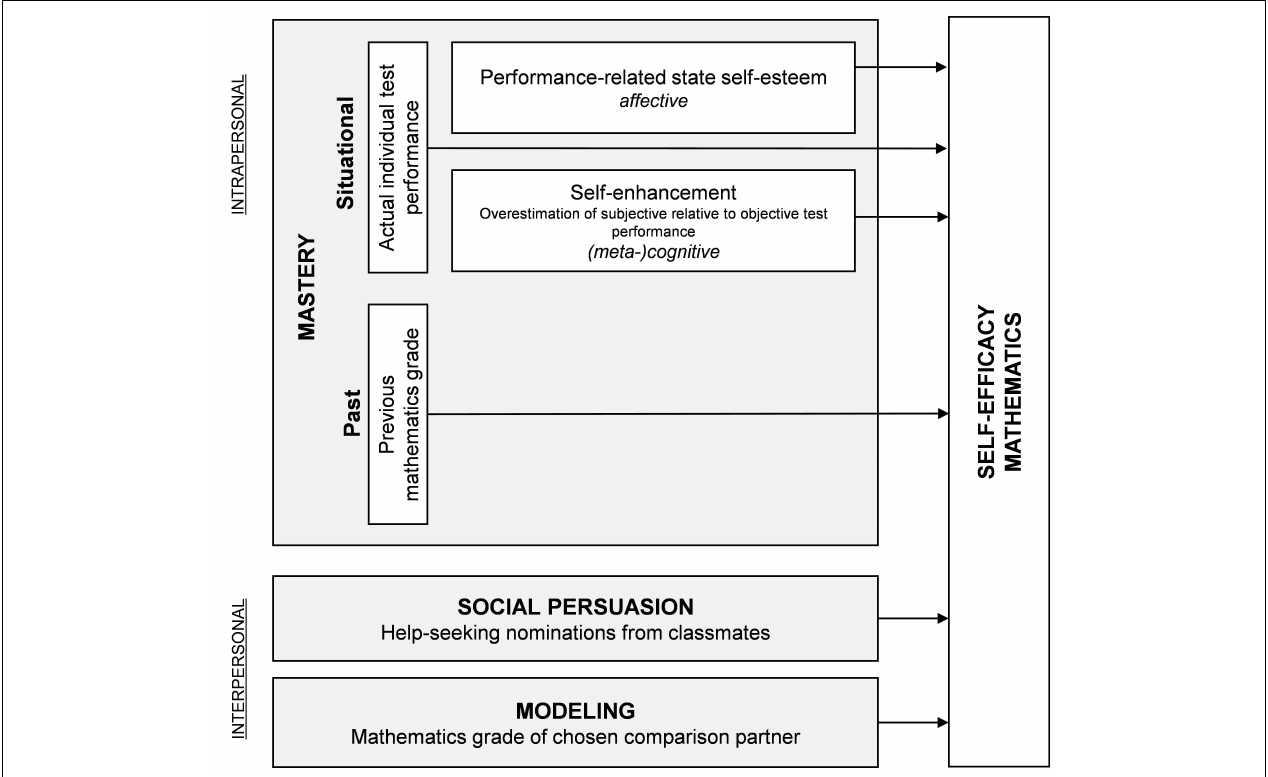
FIGURE 1 | Conceptual model of the predictors of mathematics self-efficacy including (proxy)